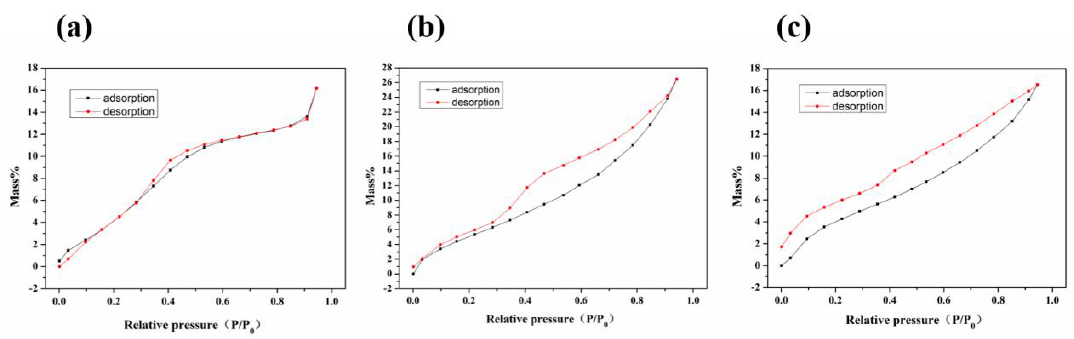
Figure 6. Water adsorption/desorption isotherms of the ( a ) SiO 2, ( b ) SG 0.30, and ( c ) SG 1.00 samples at 298 K.